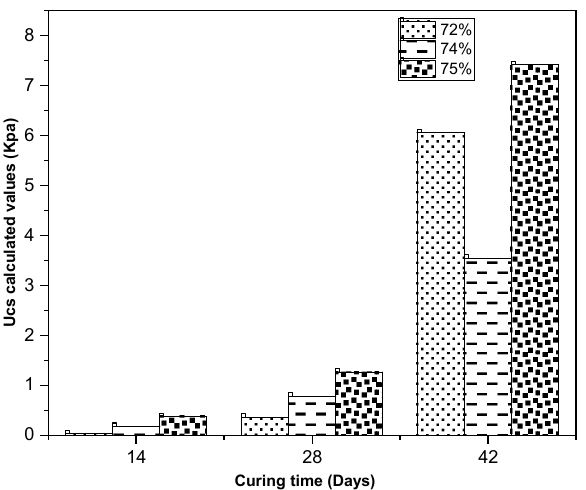
Figure 10. Effect of the solids content of CWTB mixtures prepared with 1 wt. %, 3 wt. % and 5 wt. % OPC binder on the variation in UCS Calculated with curing time.